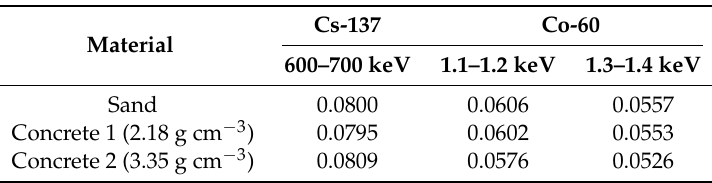
Table 2. Average mass attenuation coefficients for different materials at the photopeak region of Cs-137 and Co-60 calculated from